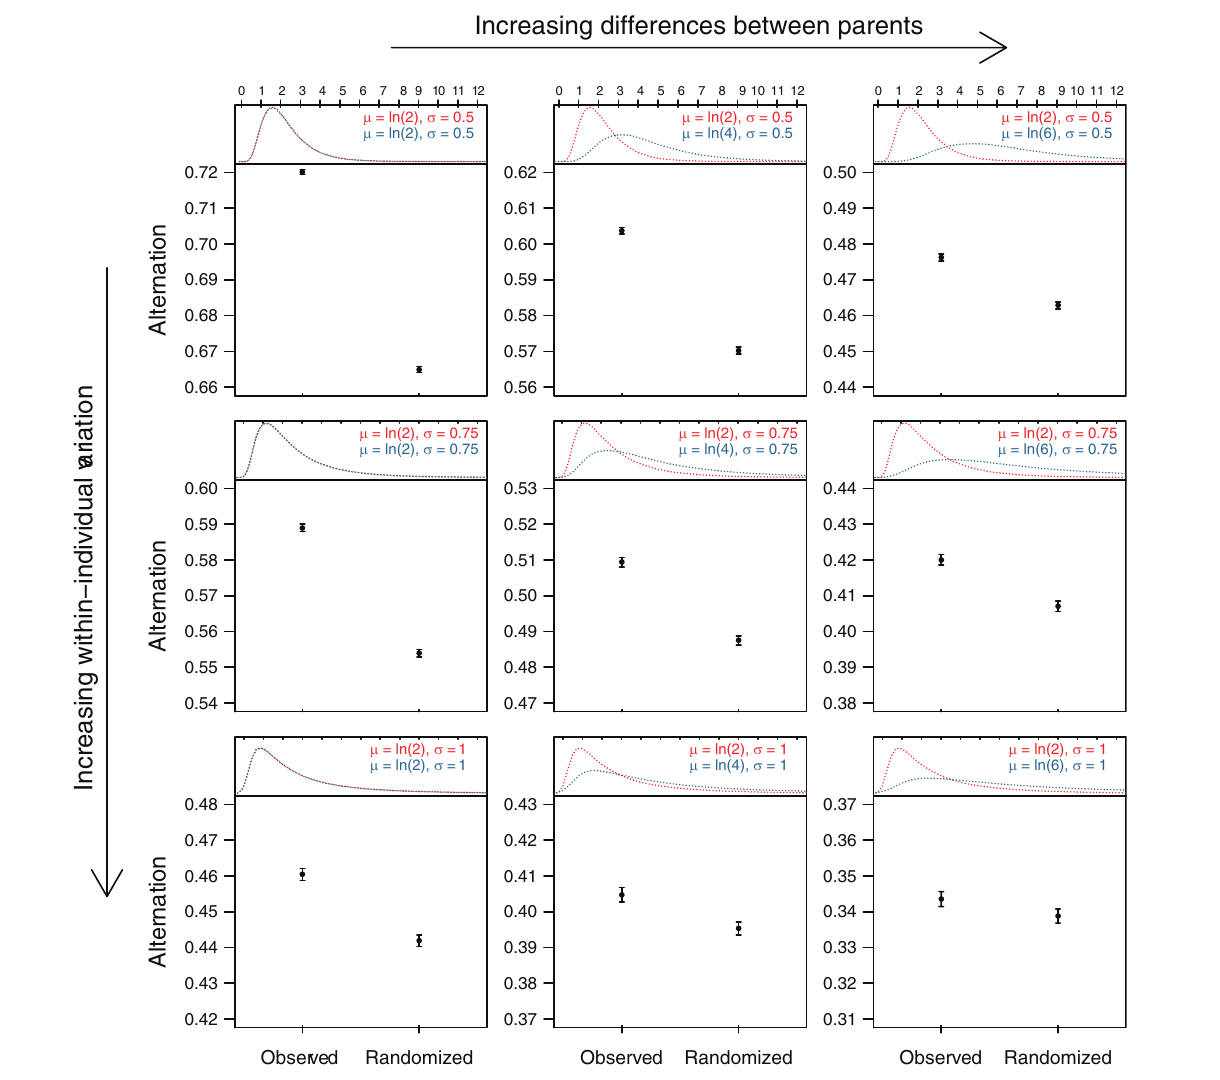
FIGURE 2 | Observed and randomized levels of alternation for simulated sequences with different levels of within- and between-parent variation in inter-visit intervals (IVI). We simulated feeding sequences for pairs of provisioning parents where IVIs of each parent were drawn from a log-normal distribution with parameters µ and σ (i.e., the natural logarithm of the variable is normally distributed with mean µ and standard deviation σ ). The median IVI (e µ ) of one parent could be either the same, twice as much, or three times as much as that of the other parent, and σ of either parent could be 0.5, 0.75, or 1. The top part of each panel shows the resulting distributions with the IVI (in minutes) on x-axis. To simulate the effect of an external stimulus that increased IVI’s (e.g., a predator), we created for each combination of within- and between-parent variation another set of IVI’s in which the median was increased by a factor of two (distributions not shown). Feeding sequences of 120min were then constructed, in which the first and last 30min were randomly drawn (for each parent separately) from the original simulated IVI’s, while the middle 60min were drawn from the simulated IVI’s that reflected the presence of a predator [as per scenario (C) in Figure 1 ]. We then generated 1,000 such sequences for each combination of within- and between-parent variation and calculated the level of alternation (see legend of Figure 1 ) before and after randomization. The lower part of each panel shows means and standard errors of these “observed” and “randomized” alternation levels. Code for data generation is provided in the Supplementary Materials